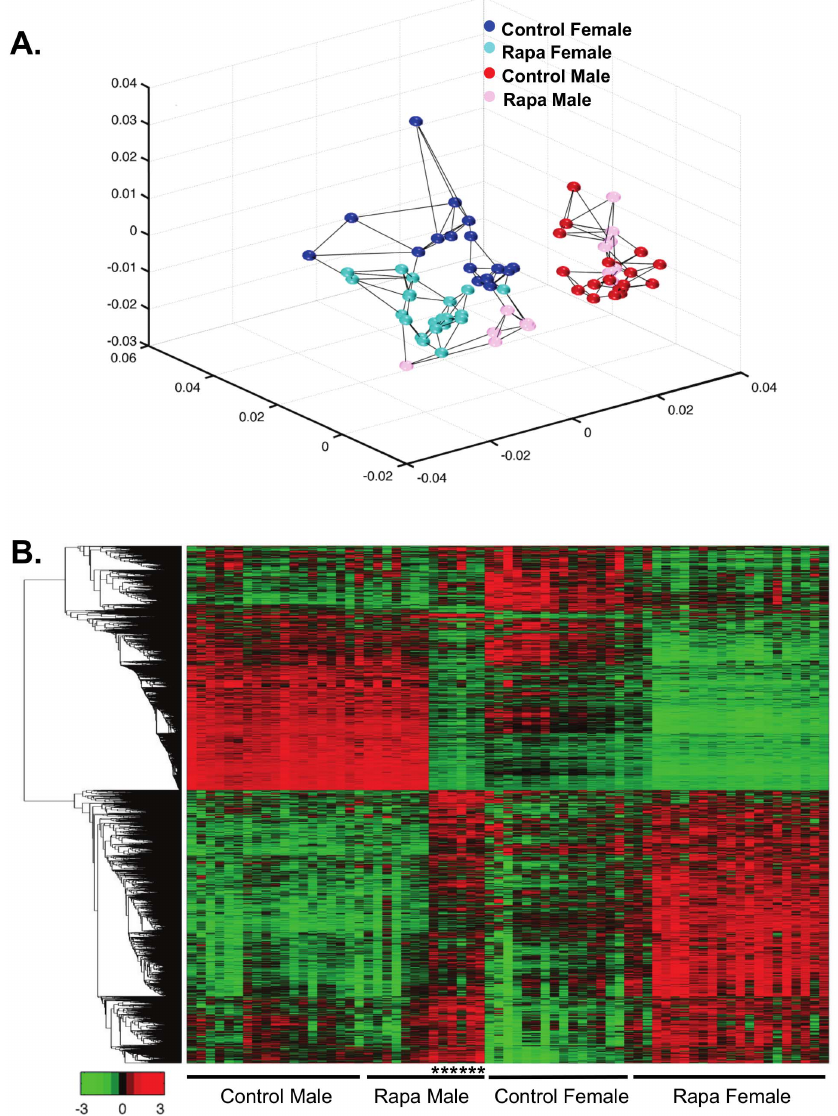
Figure 3. Multidimensional scaling and heatmap analyses shows the separations of Rapa and control groups. Multidimensional scaling analysis was conducted using all the probes detected (25,697 probes) on the microarrays ( A ). Control males are shown in red, Rapa males in pink, control females in blue, and Rapa females in cyan. Each dot represents one sample and the lines indicate the three nearest neighbors. In the females, the Rapa mice segregate separately from the control mice, while in the males, 7 Rapa mice group similar to the control males and 6 of the Rapa males do not group with the control males. From this analysis, we separated the Rapa males into two groups for subsequent analysis, Rapa-1 males as the group that appears similar to the control males and Rapa-2 males as the group that appears different from the control males. The heatmap analysis shows the expression of all transcripts that were observed to change significantly with Rapa in both male and female mice ( B ). The genes were clustered using linkage hierarchical cluster with Euclidean distance. The transcript expressions are shown with red for high, black for middle, and green for low expression. The male mice in Rapa-2 are shown by the asterisks. A list of the transcripts that significantly changed with chronic Rapa feeding is shown in the same top to bottom clustering order as the heatmap in File S2,